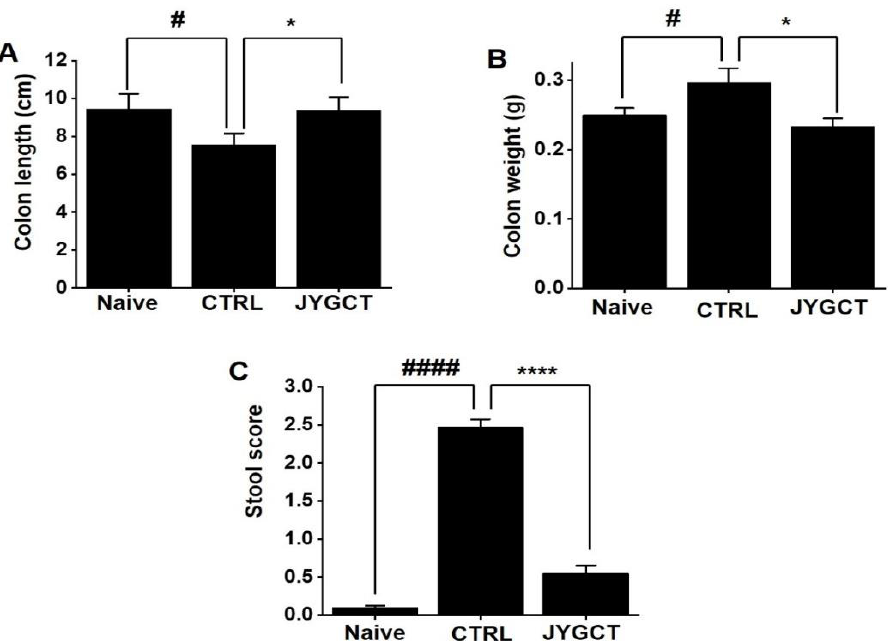
Figure 6. Effects of JYGCT on zymosan-induced colonic changes. ( A ) Colon length; ( B ) Colon weight; ( C ) Stool scores were analyzed. Bars represents the mean ± SE. * p < 0.05. # p < 0.05. #### p < 0.0001. **** p < 0.0001. JYGCT: Jakyakgamcho-tang; CTRL: control.